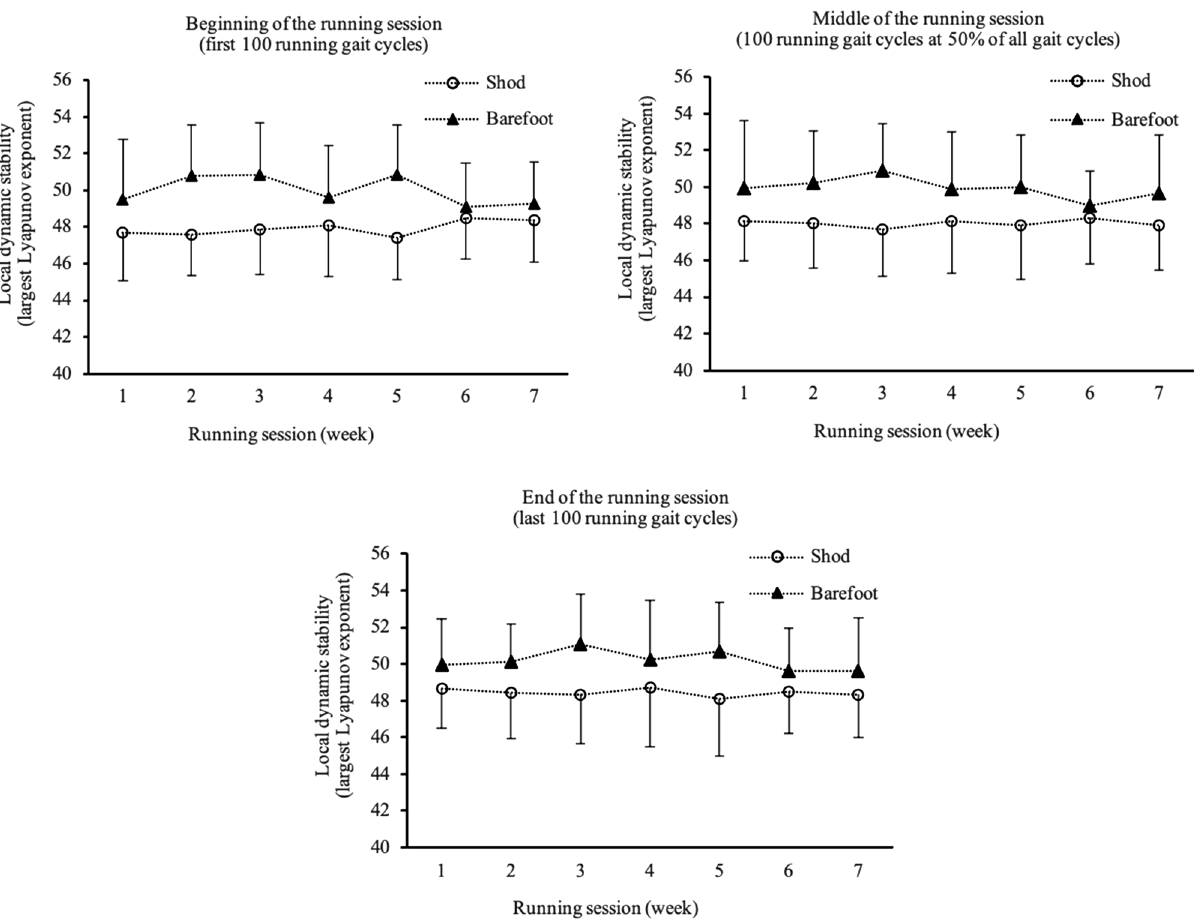
Figure 3. Local dynamic (running) stability (largest Lyapunov exponent) depicted for all seven running sessions for the beginning (3a), middle (3b) and end (3c) of the 15-min